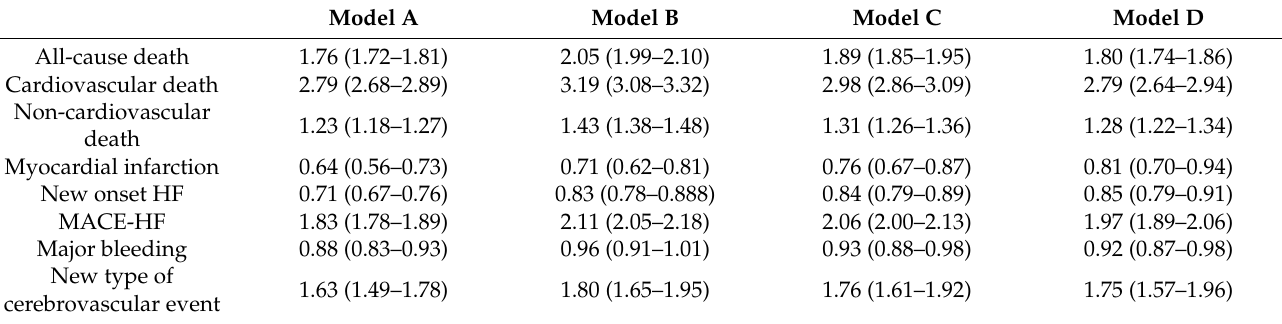
Table 3. Hazard ratios (95% CI) associated with incident outcomes in non-traumatic intracranial hemorrhage with no atrial fibrillation (versus ischemic stroke